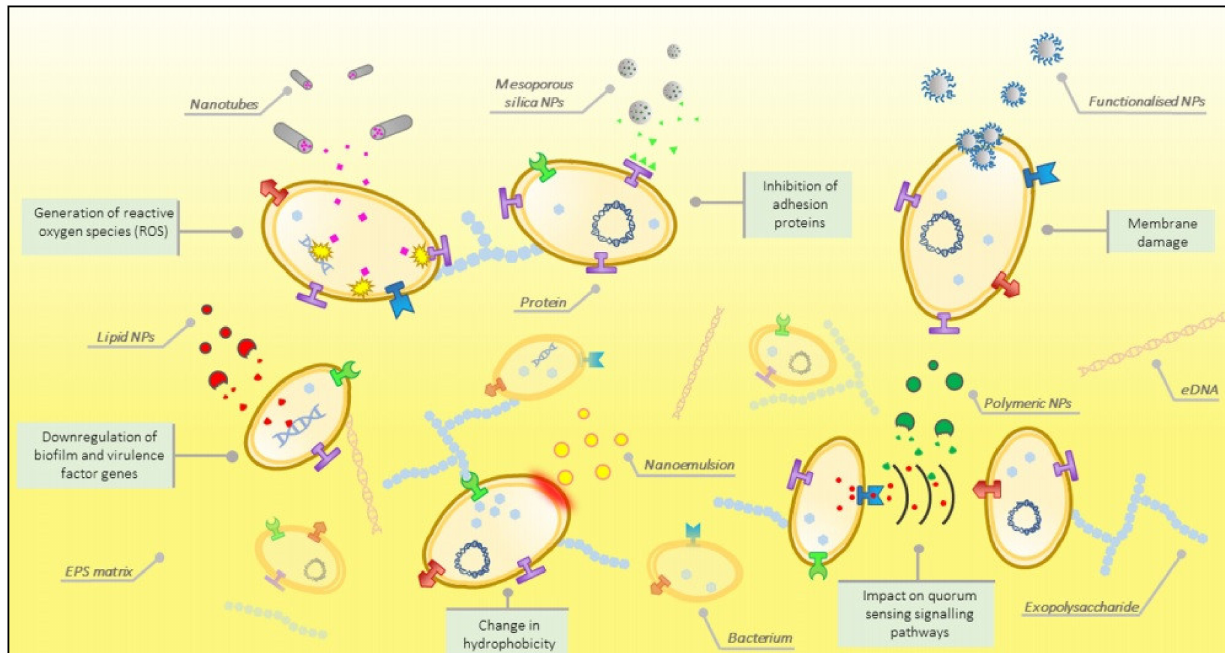
Figure 1. Illustration of mechanisms that can affect bacterial biofilms by nano-formulations and nanoparticles conjugated with natural products. Reprinted with permission from ref. [38]. Copyright 2020, American Chemical